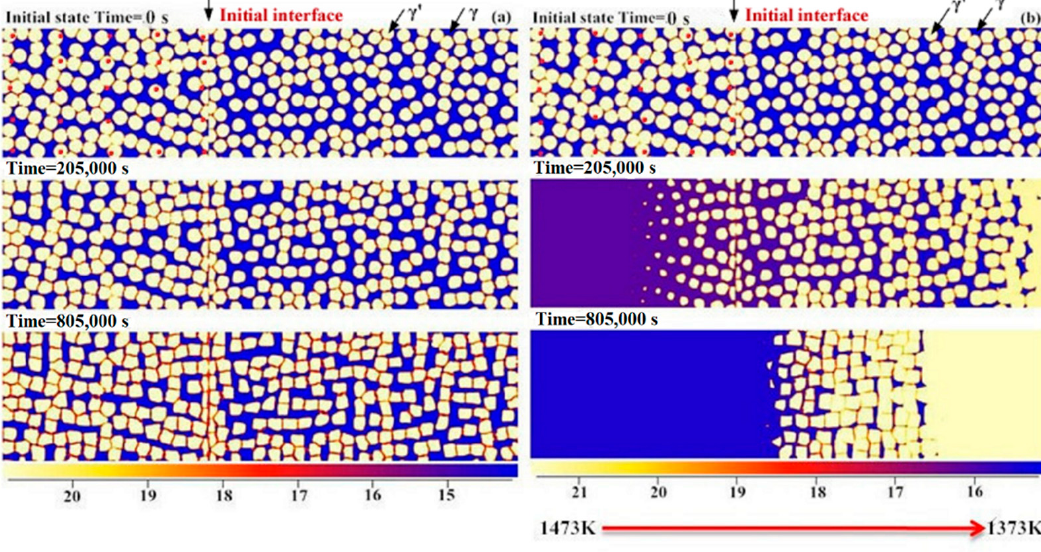
Figure 3. Phase-field simulated microstructure evolution of No. 5 γ + γ '/ γ + γ ' bond coat/substrate system (Ni–18.5at.%Al–11.25at.%Cr/Ni–18at.%Al–12at.%Cr) annealed ( a ) at 1373 K and ( b ) with an effect of temperature gradient Δ G = 5000 K/cm. The color bar scale indicates the mole fraction of Al in atom percent.